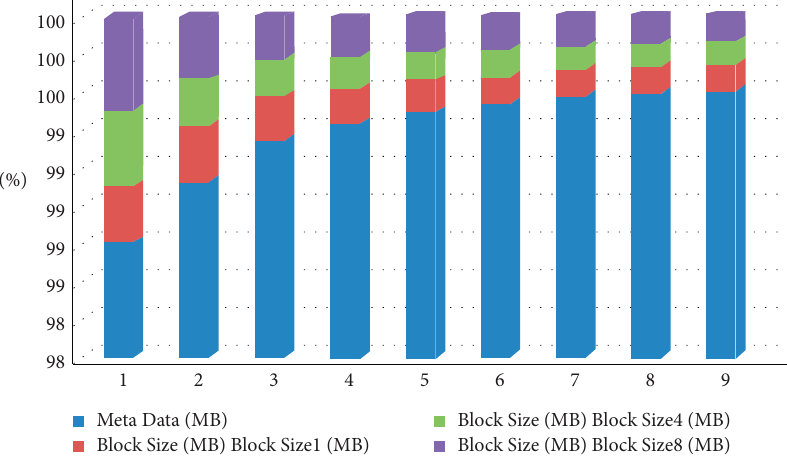
Figure 6: 1 ∼ 10GB data proof-verifcation